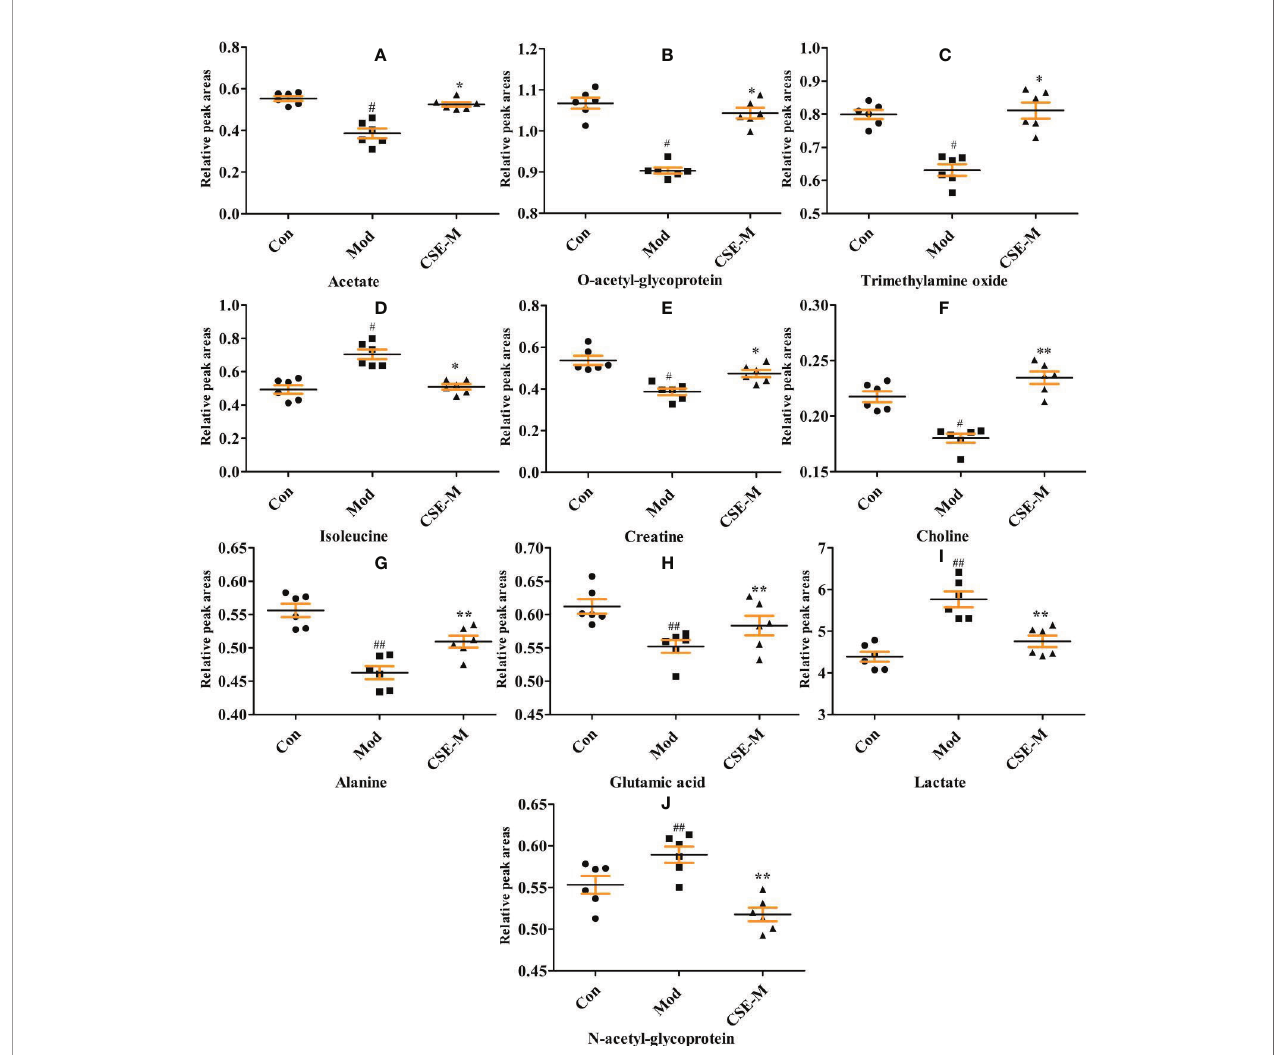
FIGURE 9 | Comparison of relative peak areas of the potential metabolites in 1H-NMR associated with CSE treatment in serum. The data are presented as means ± SEM (n = 6). ## P < 0.01, # P < 0.05 compared with the control group. **P < 0.01, *P < 0.05 compared with the model group. The 10 metabolites were: (A-J) acetate, O-acetyl-glycoprotein, trimethylamine oxide, isoleucine, creatine, choline, alaline, glutamic acid, lactate,